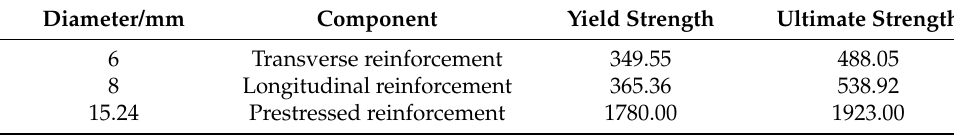
Table 3. Test strength of reinforcements (strength unit: